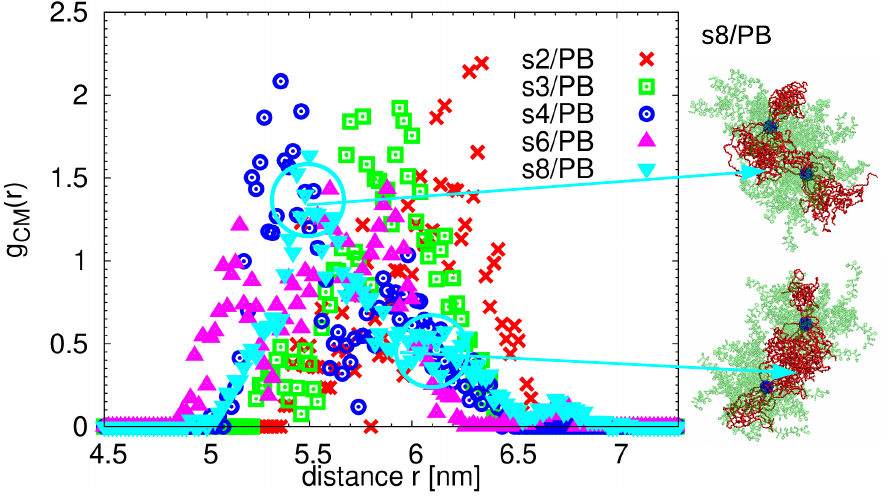
Figure 6. The radial distribution function of the mutual distances of the centers-of-mass of the nearest neighbor stars in the self-assembled object. Representative snapshots for selected distances highlighted by circles are shown on the right for the s8/PB